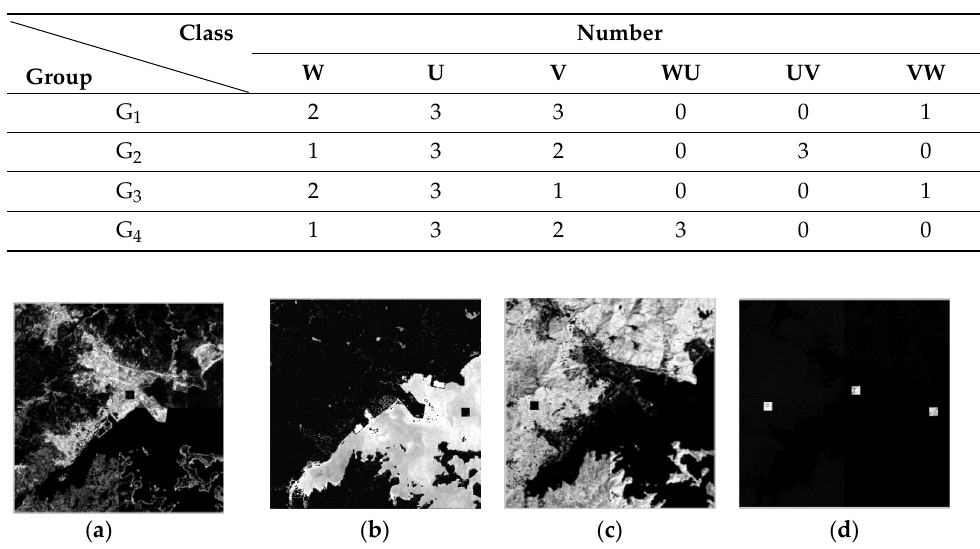
Figure 5. The abundances in the entire image: ( a ) urban (U); ( b ) water (W); ( c ) vegetation (V) and ( d ) all of the changed classes (VW, UV and WU).